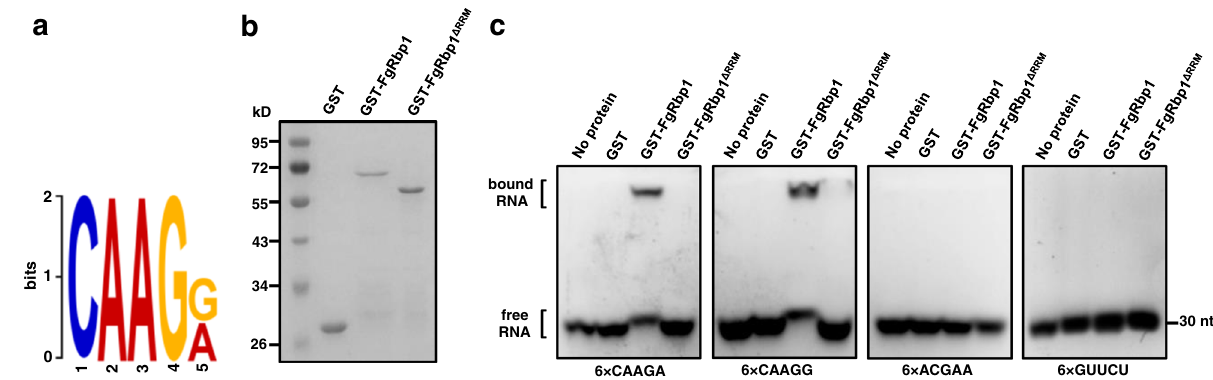
Fig. 4 FgRbp1 binds the CAAGR cis element. a Sequence logo of the enriched motif among the peak sequences of FgRbp1 target genes. The y axis (letter size) indicates the information content (bits) of each position. b GST-FgRbp1 and GST-FgRbp1 Δ RRM were expressed in E. coli , puri fi ed using glutathione sepharose, resolved by SDS-PAGE on a 12.5% acrylamide gel, and stained with coomassie blue. The size of relevant molecular weight markers (MWM) are indicated on the left. c In vitro binding of FgRbp1 to the CAAGR motif in the EMSA assay. Synthetic six repeats of 5 ’ -CAAGA-3 ’ , 5 ’ -CAAGG-3 ’ , 5 ’ -ACGAA- 3 ’ and 5 ’ -GUUCU-3 ’ sequences were incubated alone or with GST, GST-FgRbp1, or GST-FgRbp1 Δ RRM for 5 min at room temperature and separated on a 2.0% agarose